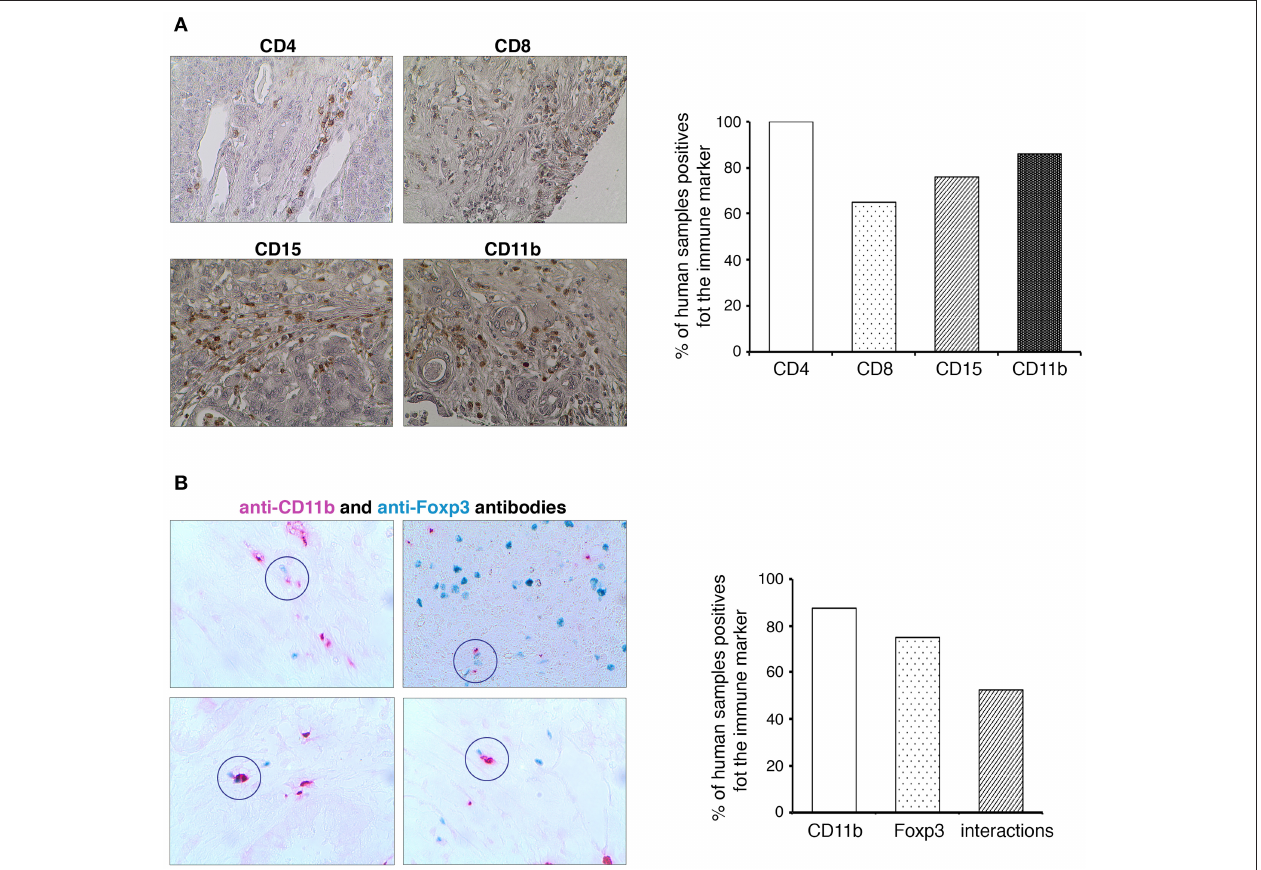
FIGURE 6 | Identification of MDSCs and Treg cells crosstalk in human PDAC. (A) Formalin-fixed, paraffin-embedded tissue sections of human pancreatic cancer were stained with anti-CD4, anti-CD8, anti-CD15, and anti-CD11b antibodies. All immunohistochemistry experiments were performed with the Vector Kit. Histograms show the quantification of the different immune markers expression in PDAC. Original magnification x100. (B) Formalin-fixed, paraffin-embedded tissue sections of human pancreatic cancer were stained with anti-Foxp3 (in Emerald) and anti-CD11b (in Permanent-red) antibodies. All immunohistochemistry experiments were performed with the GBI Labs Kit. A visual evaluation of interactions between Foxp3 + and CD11b + cells was performed on human PDA tissues. Histograms show the quantification of the markers expression in PDAC and the presence of their interactions.